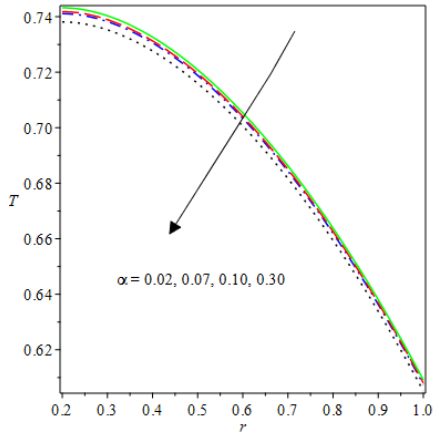
Figure 15. Heat transfer for rising ( α )